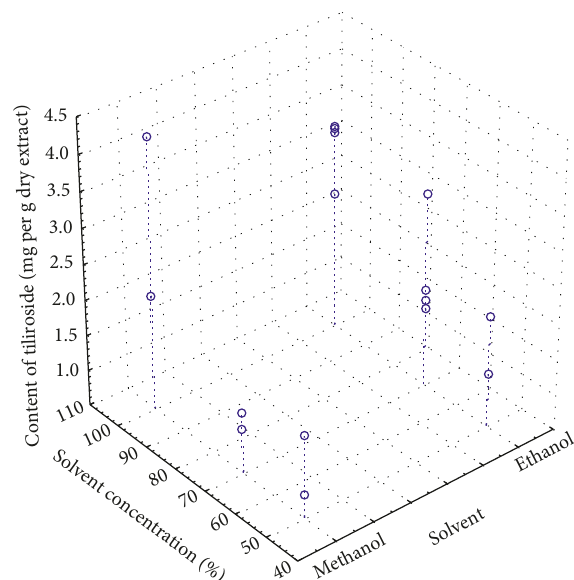
Figure 3: Spread chart 3W of the content of tiliroside vs. type of solvent and solvent concentration for accelerated solvent extraction